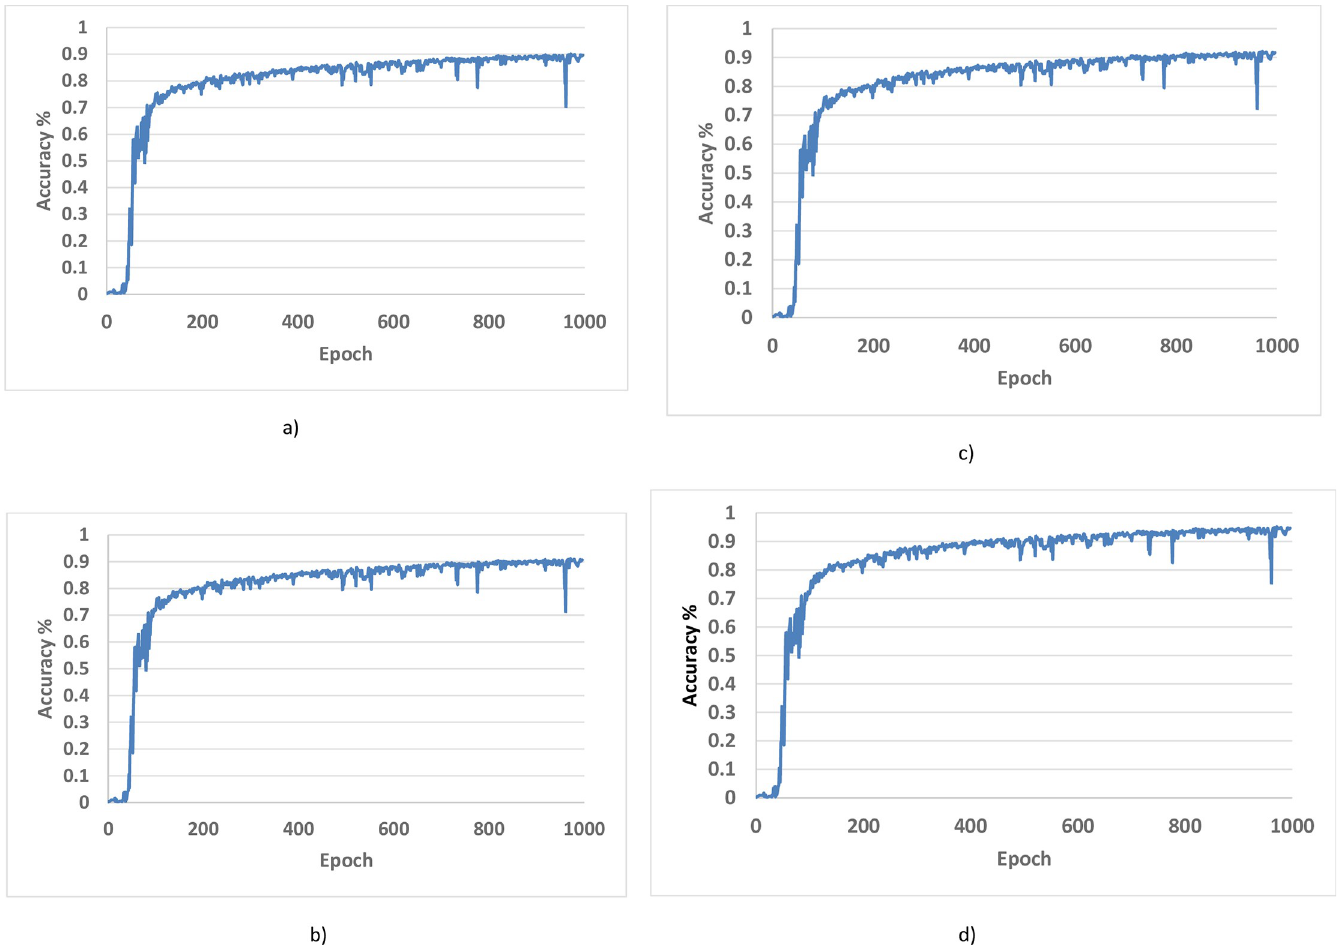
Fig 7. Cross validation accuracy (SSCA) using different labeled rates. (a) Labeled Rate 20% b) Labeled rate 40% c) Labeled rate 60% d) Labeled rate 80%.